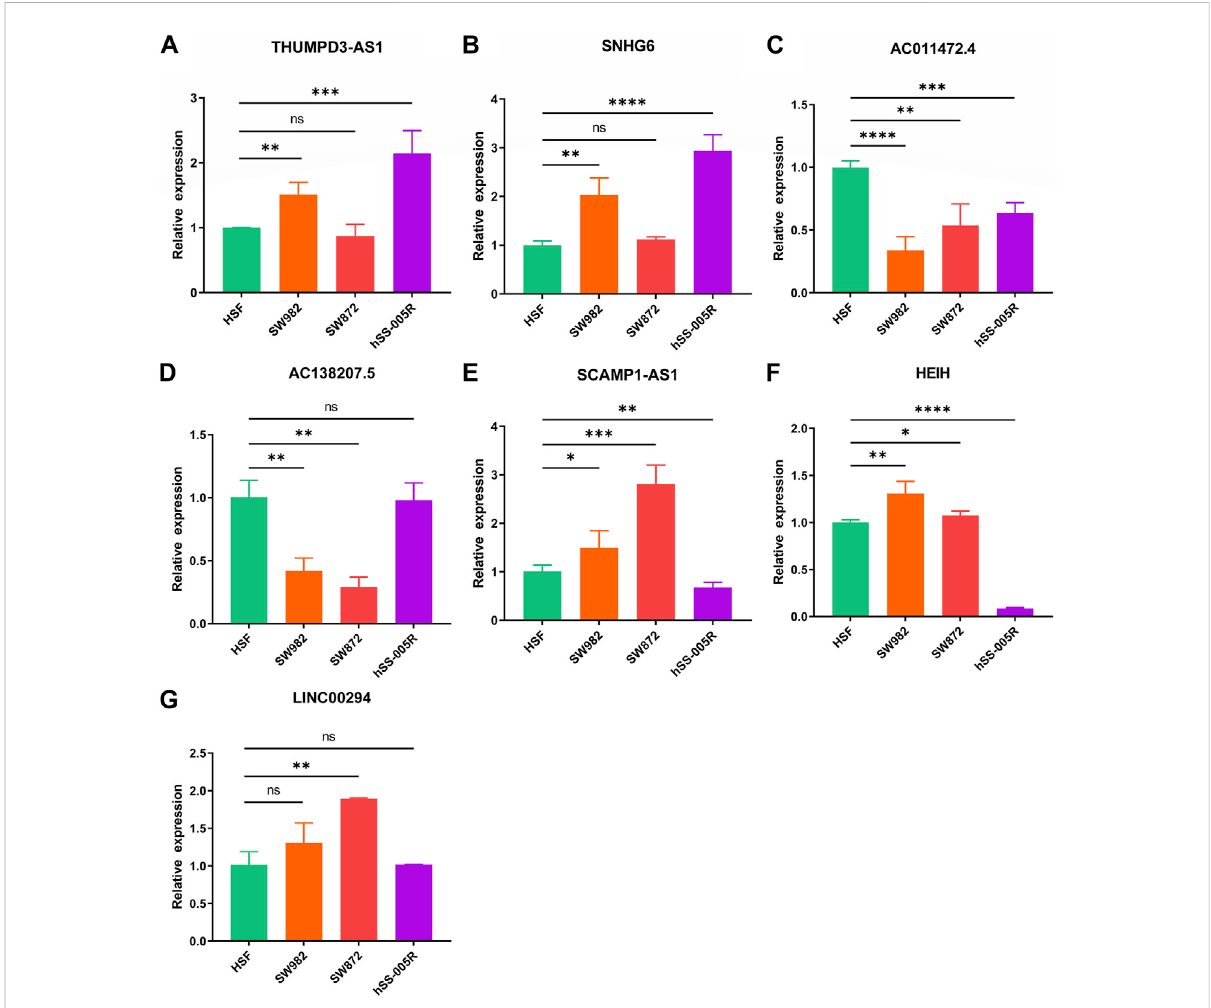
FIGURE 12 Veri fi cation of the expression of signature CRLs in OS cell lines. (A) THUMPD3-AS1. (B) SNHG6. (C) AC011472.4. (D) AC138207.5. (E) SCAMPA- AS1. (F) HEIH. (G) LINC00294. * p < 0.05, ** p < 0.01, *** p < 0.001, **** p <